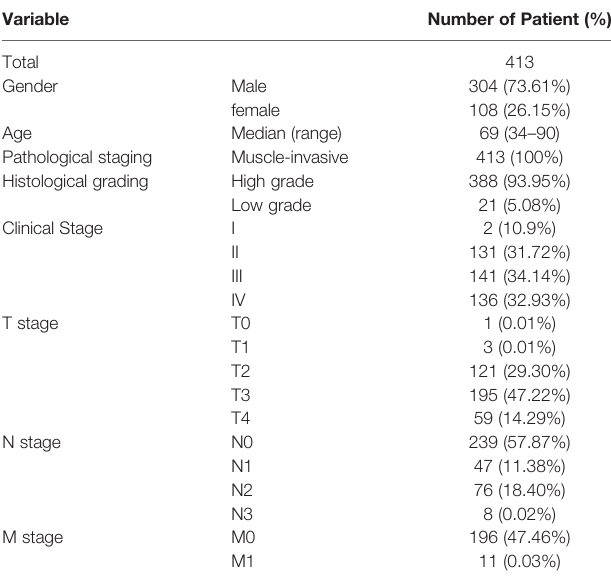
TABLE 1 | Characteristics of 413 patients with bladder cancer from the